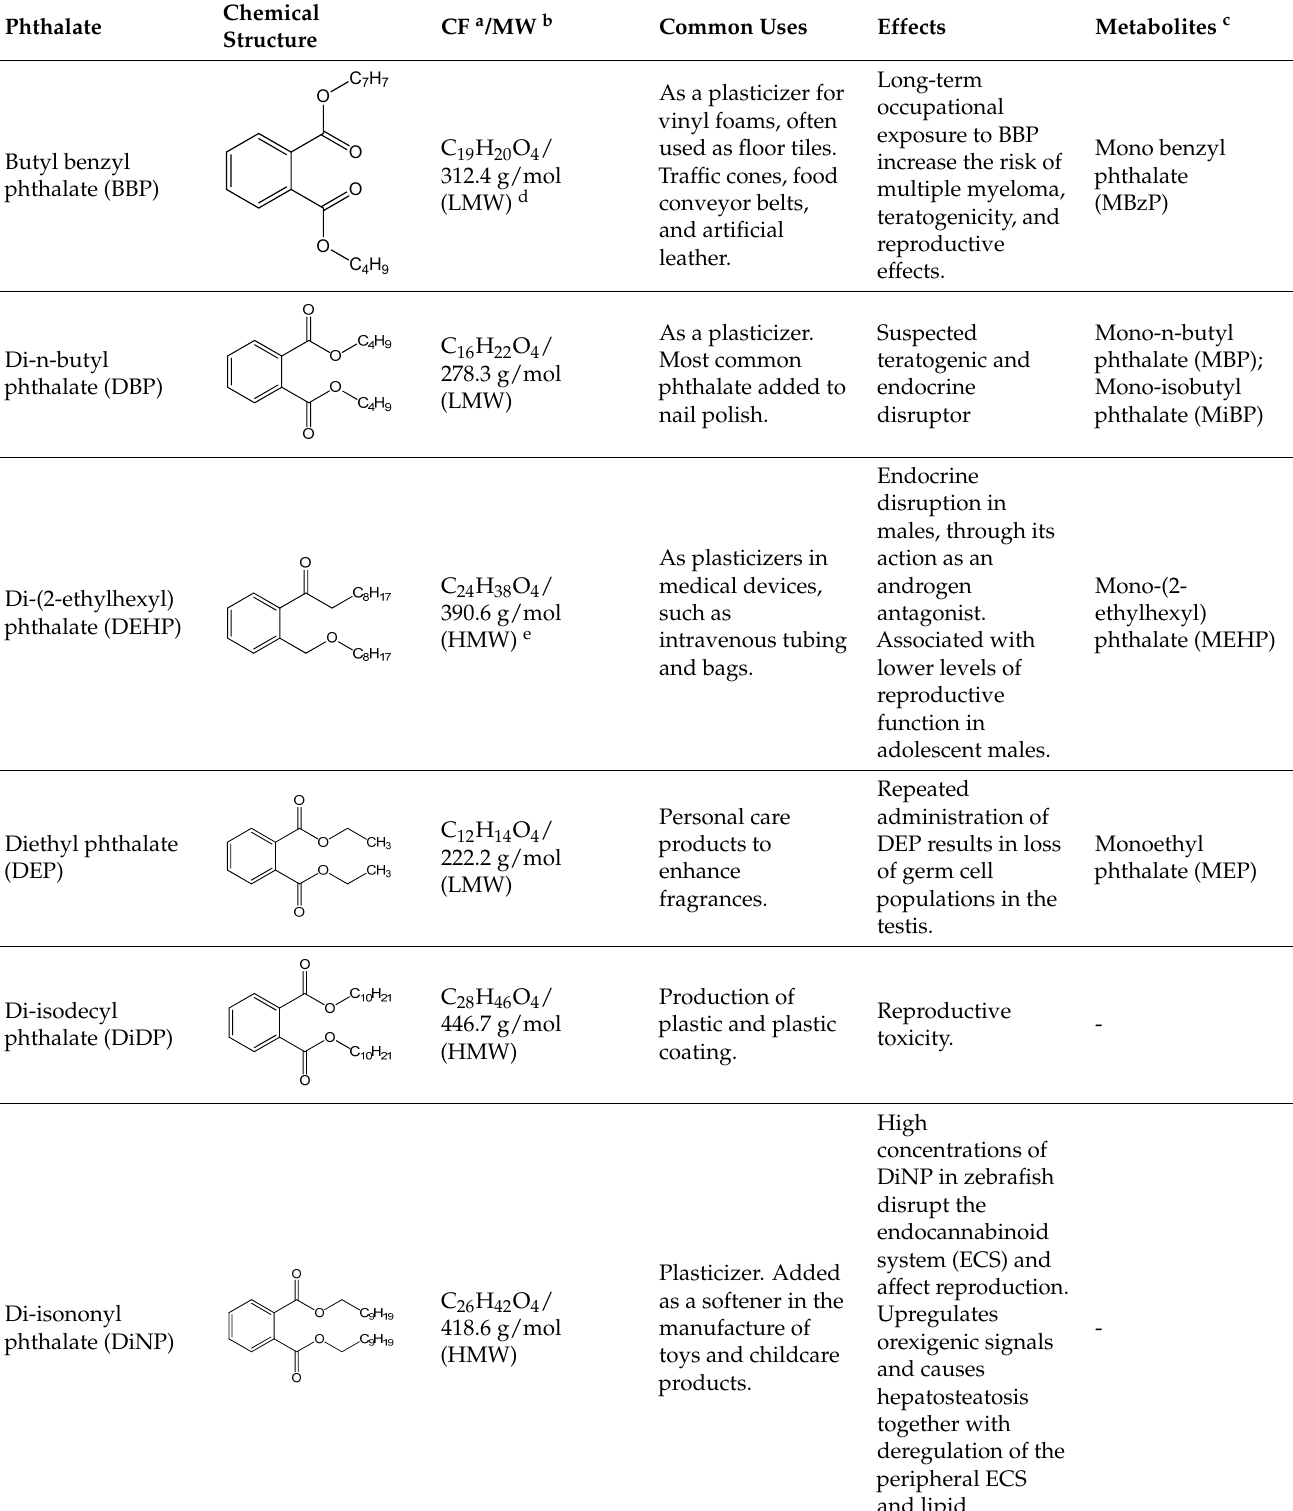
Table 1. The most widely used PAEs and their metabolites